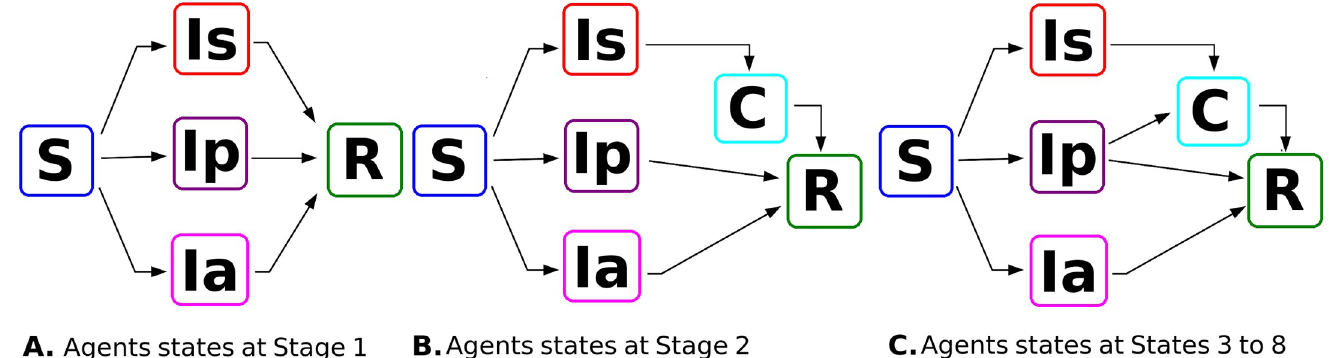
Fig 1. Possible states of the agents throughout the simulation. Susceptible S, symptomatic Is, presymptomatic Ip, asymptomatic Ia, and recovered R. Since Stage 2, we also have the Confined state C.